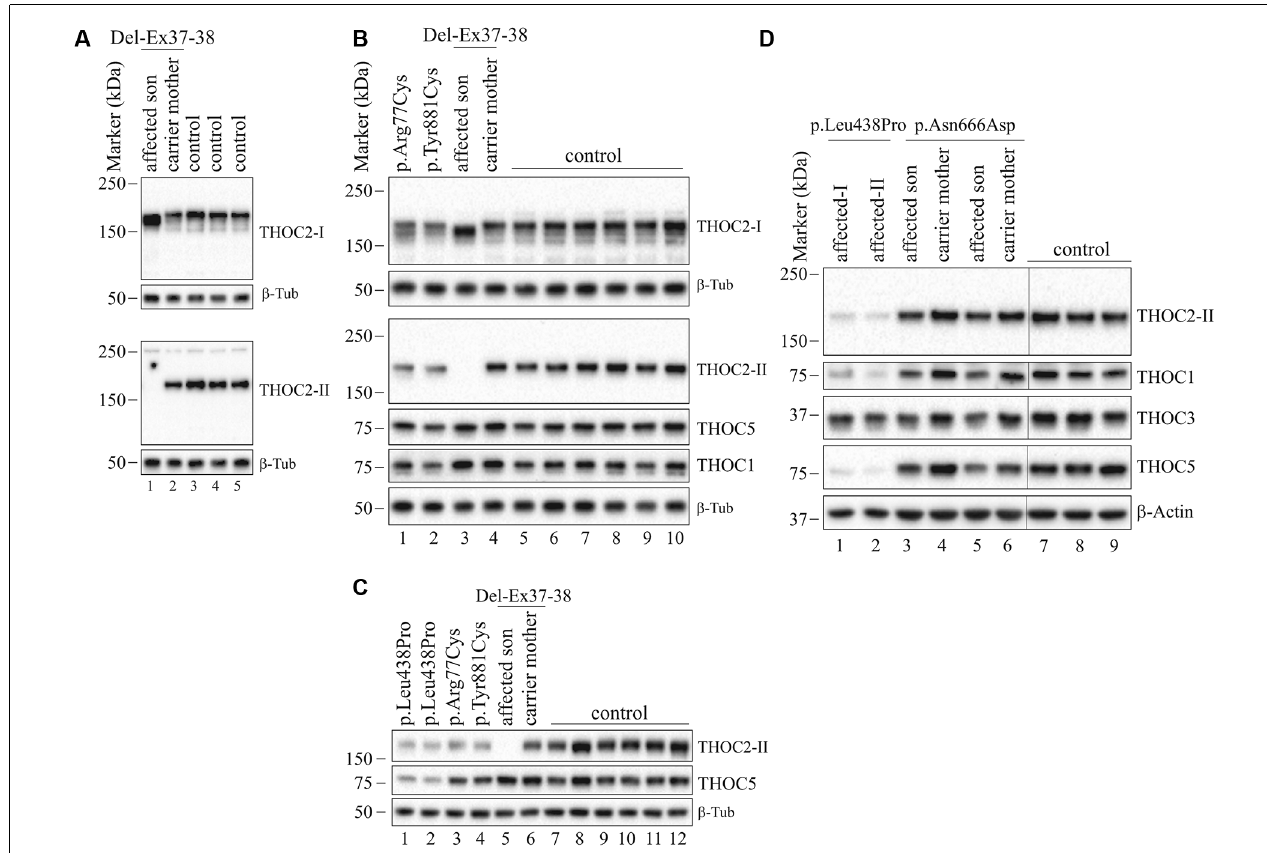
FIGURE 5 | THOC2 variant protein analysis in patient-derived cell lines. (A) THOC2 protein in affected son with Del-Ex37-38, unaffected carrier mother and control fibroblasts. Total protein lysates were western blotted with an anti-THOC2-I antibody that binds to a region between amino acids 1,400–1,450 coded by Ex32-34 mRNA (upper panel) and anti-THOC2-II antibody that binds to a region between amino acids 1543–1593 coded by Ex37-38 mRNA (lower panel). Samples were probed for β -Tubulin as a loading control. (B) THOC2 protein in p.Arg77Cys, p.Tyr881Cys, affected son with Del-Ex37-38, unaffected carrier mother and control LCLs. Total protein lysates were western blotted with anti-THOC2-I, anti-THOC2-II, anti-THOC1, anti-THOC5 and anti- β -Tubulin (loading control) antibodies. Del-Ex37-38 affected fibroblasts (Lane 1 in panel A ) and LCLs (Lane 3 in panel B ) showing presence of a C-terminally deleted smaller but higher levels of the THOC2 protein when western blotted with anti-THOC2-I antibody (upper panels) that is absent in the affected fibroblast lysates probed with anti-THOC2-II antibody (lower panels). However, normal full-length THOC2 protein is present in the carrier mother and controls western blotted with both the anti-THOC2-I and anti-THOC2-II antibodies (Lane 2 in upper and lower panels in A and Lane 4 in upper and lower panels in B ). The p.Arg77Cys and p.Tyr881Cys THOC2 levels are reduced. (C) THOC2 protein levels in p.Leu438Pro (reported to have reduced protein stability; Kumar et al., 2015), p.Arg77Cys, p.Tyr881Cys, Del-Ex37-38 affected son, his unaffected carrier mother and control LCLs. Total protein lysates were western blotted with anti-THOC2-II, anti-THOC5 and anti- β -Tubulin (loading control) antibodies. (D) The p.Asn666Asp levels are moderately reduced in the affected fibroblasts. p.Asn666Asp affected son, his unaffected carrier mother and control fibroblast total lysates were western blotted with the antibodies as shown. p.Leu438Pro fibroblasts previously reported having reduced THOC2 protein stability were included as controls (Kumar et al., 2015). Vertical lines on western blot images indicate the site of deleted sample